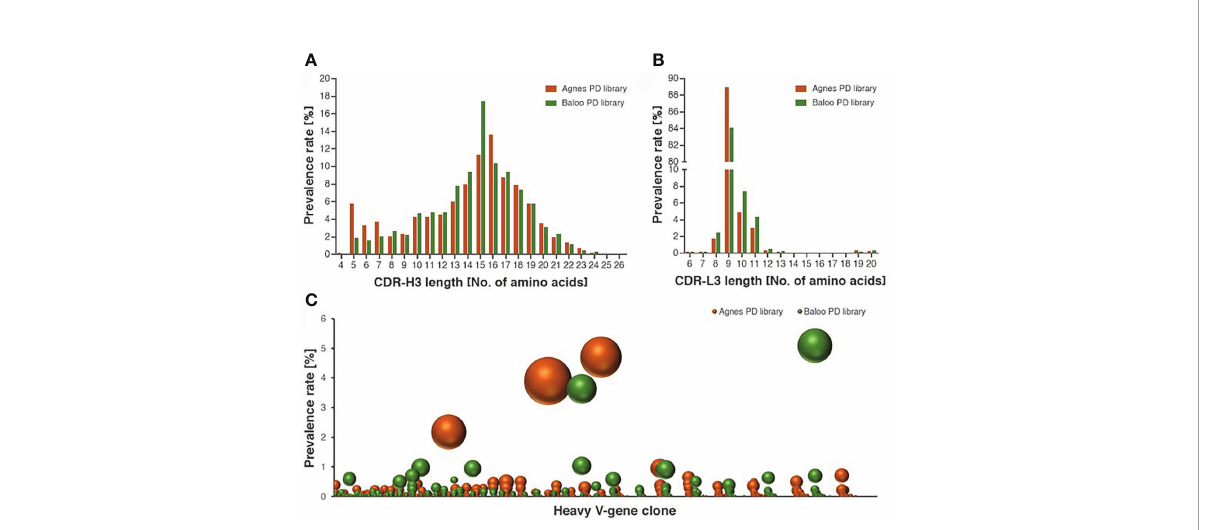
FIGURE 2 Characterization of the diversity of the equine PD library repertoires. (A, B) Length distribution of CDR-H3 (A) and CDR-L3 (B) , represented by V-segment sequences of Agnes- and Baloo-PD libraries. The histograms depict the amino-acid length of library sequences exhibiting a prevalence higher than 0.1%. (C) Prevalence rate of V-segment sequences (on the ordinate axis) assigned to each cluster (on the abscissa axis), as calculated by the clonotype analysis. Clusters composed of less than 100 sequences were not included in the chart presentation. The number of unique sequences present in each cluster is re fl ected by the sphere size (see also Supplementary Table S1 for the detailed cluster analysis